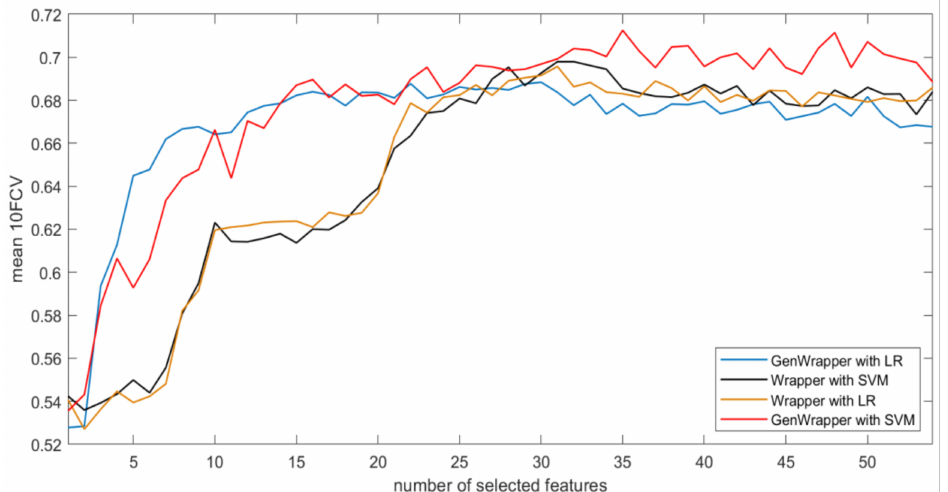
Figure 7. Accuracy (mean 10-fold cross-validation (10FCV)) with respect to selected features (curves): GenWrapper versus a classical wrapper using two classifiers (support vector machine (SVM) and logistic regression